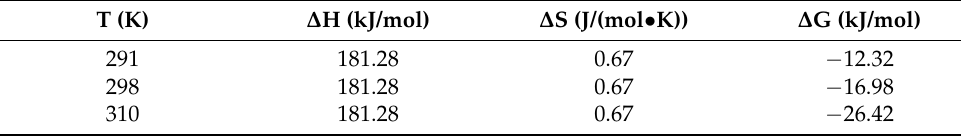
Table 3. Thermodynamic parameters for interaction between EA and zein. T